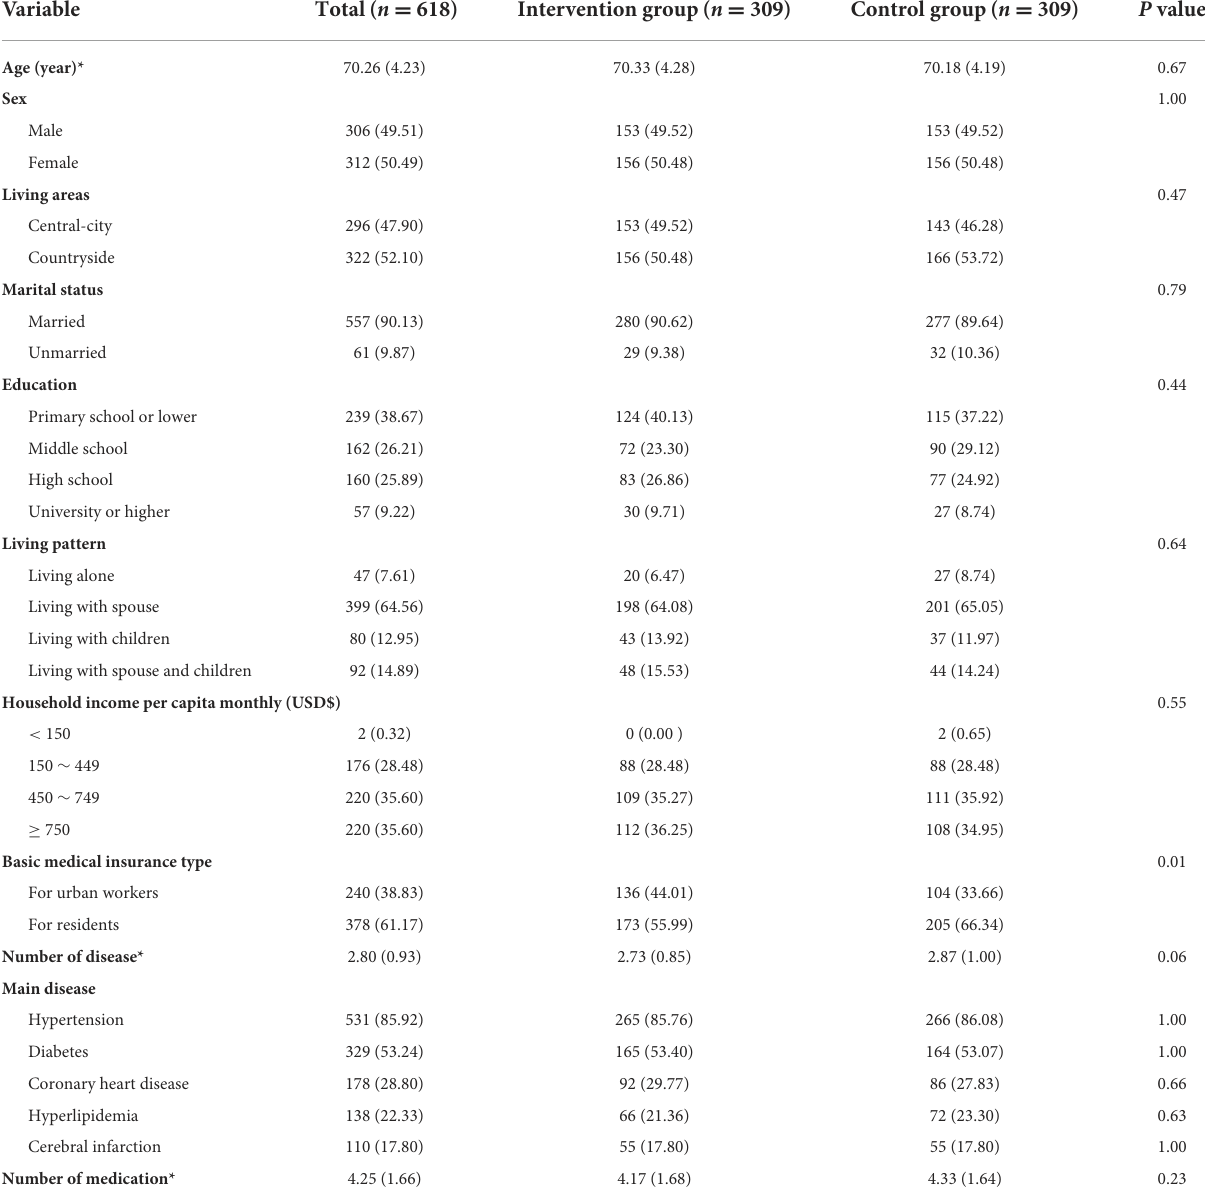
TABLE 1 Baseline characteristics of elderly patients with